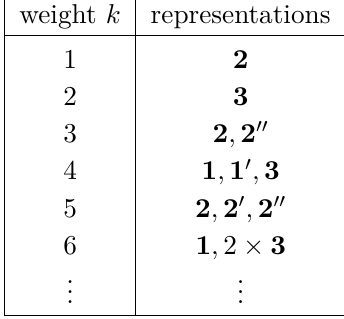
Table 1. Irreducible decomposition of M k (Γ(3))